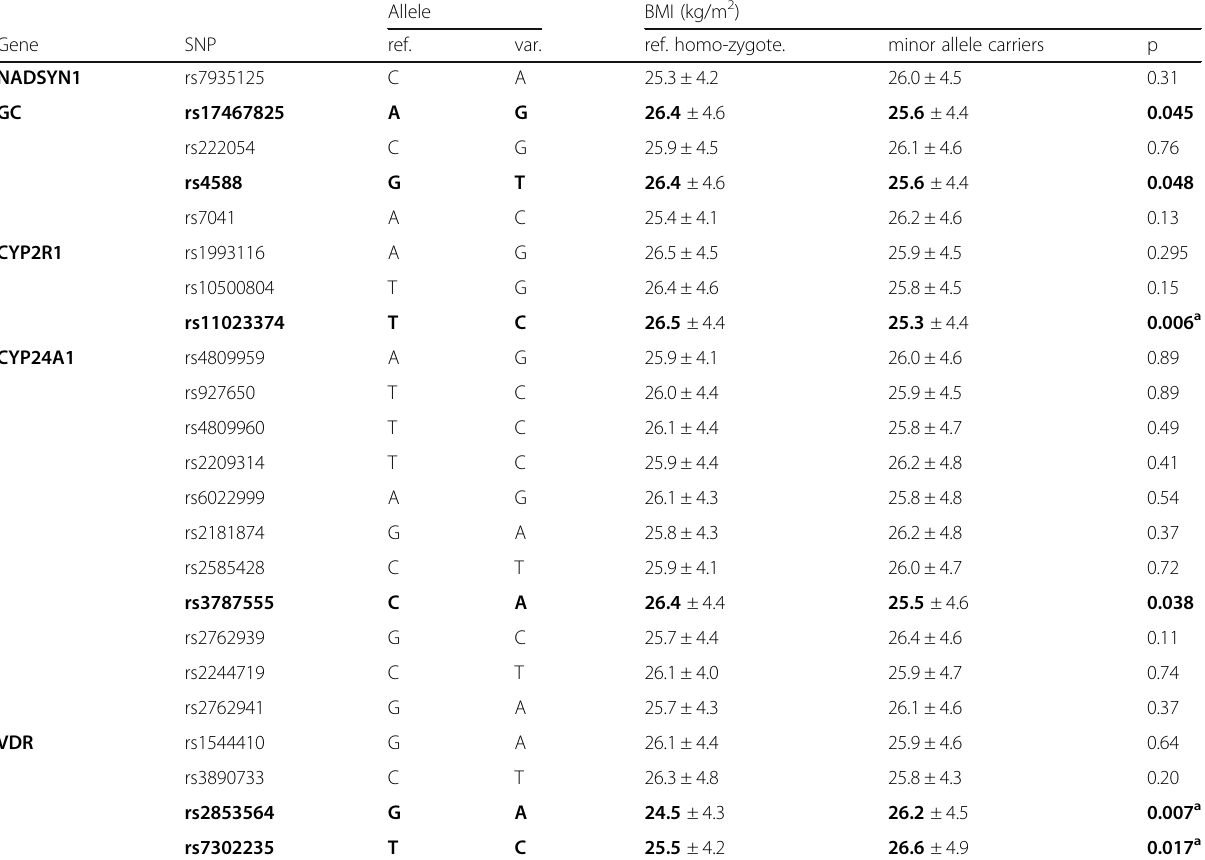
Table 2 BMI levels in subgroups defined by the investigated genotypes Allele BMI (kg/m 2 ) Gene SNP ref. var. ref.